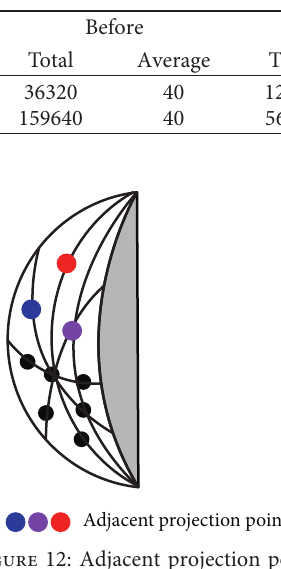
Table 8: The number of views before and after representative view